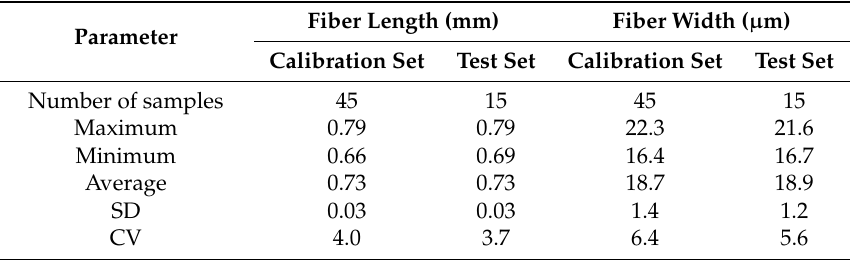
Table 1. Number of samples and range of fibre length (weighted in length) and width in the calibration set and test set, with average, standard deviation (SD) and coefficient of variation (CV). Fiber Length